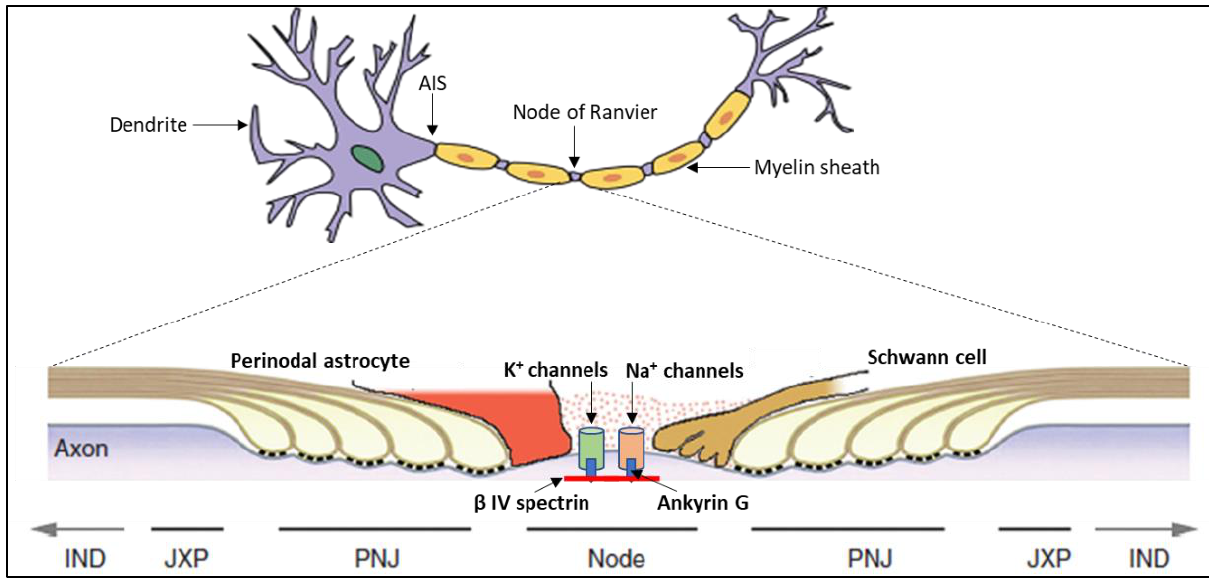
Figure 1. A detailed schematic of a Node of Ranvier.